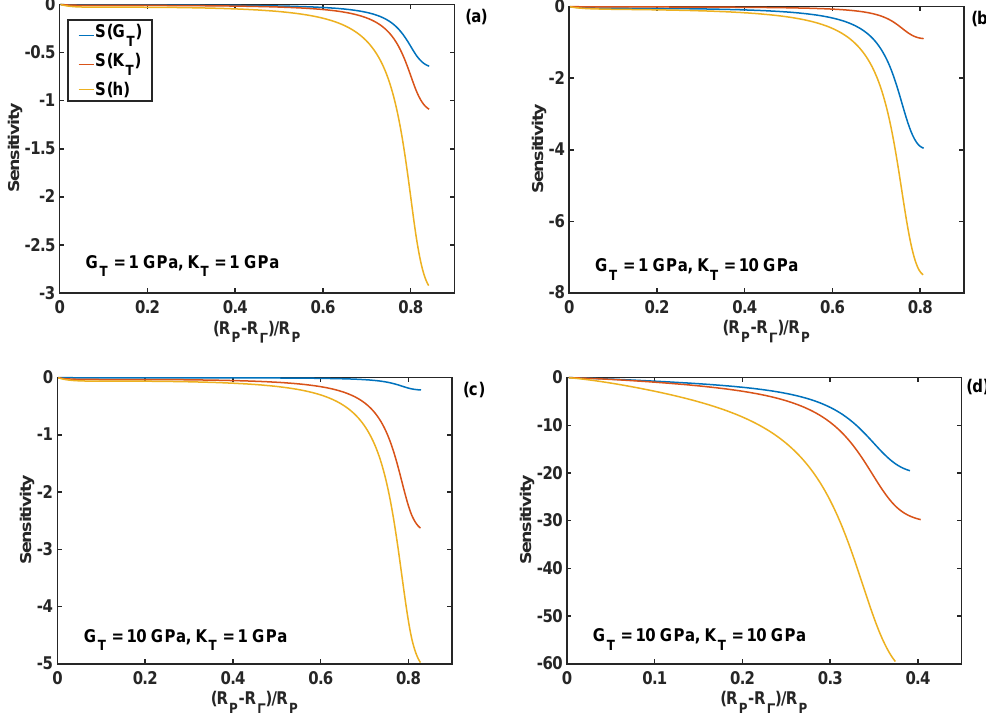
Figure 10: Sensitivity profiles of the reaction front velocity with respect to shear modulus ( G T ), bulk modulus ( K T ), and thickness ( h T ) of the coating for different combinations of shear and bulk moduli; nominal coating thickness of 10 nm is used in all simulations. ( a ) G T = K T =1 GPa; ( b ) G T = 1 GPa, K T = 10 GPa; ( c ) G T = 10 GPa, K T = 1 GPa; ( d ) G T = K T = 10